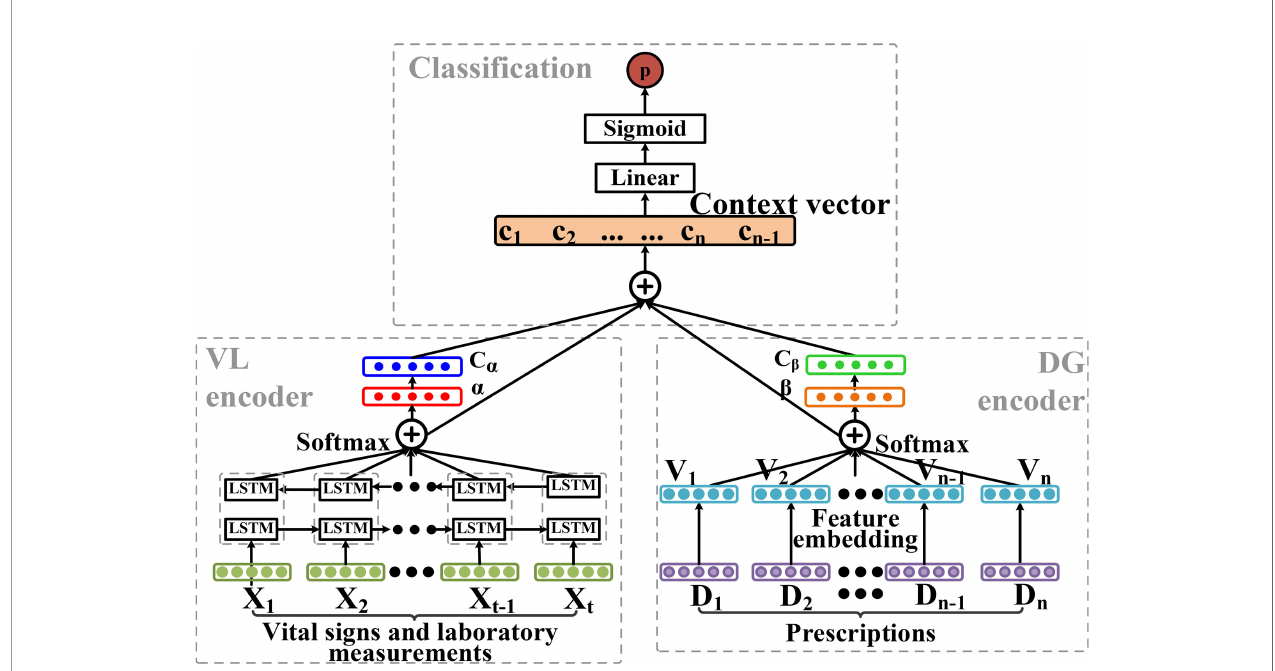
FIGURE 4 | The deep learning model architecture of bi-directional long short-term memory (LSTM) with attention (Bi-LSTM_Attn). It consists of three parts: vital sign and laboratory measurement (VL) encoder, drug (DG) encoder and the classi fi cation